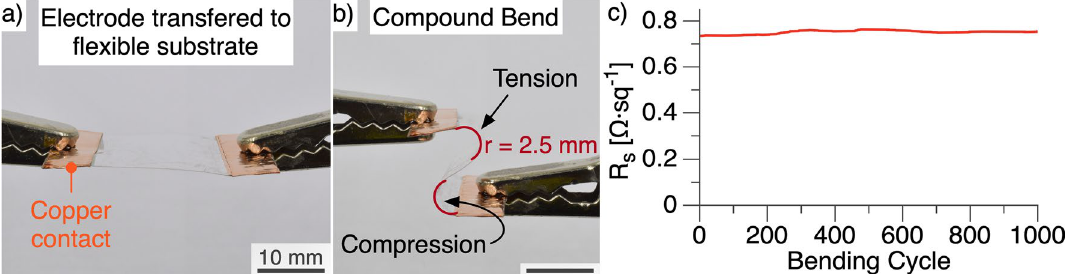
Figure 4. Mechanical durability evaluation. ( a ) Photograph of electrode after transferring onto a polypropylene substrate. ( b ) Photograph of TCE under 2.5 mm radius compound bending. Arrows indicate which areas are under compression and tension. ( c ) Sheet resistance (R s ) as a function of bending cycles. Sheet resistance increased by 2.5% after 1000 bending